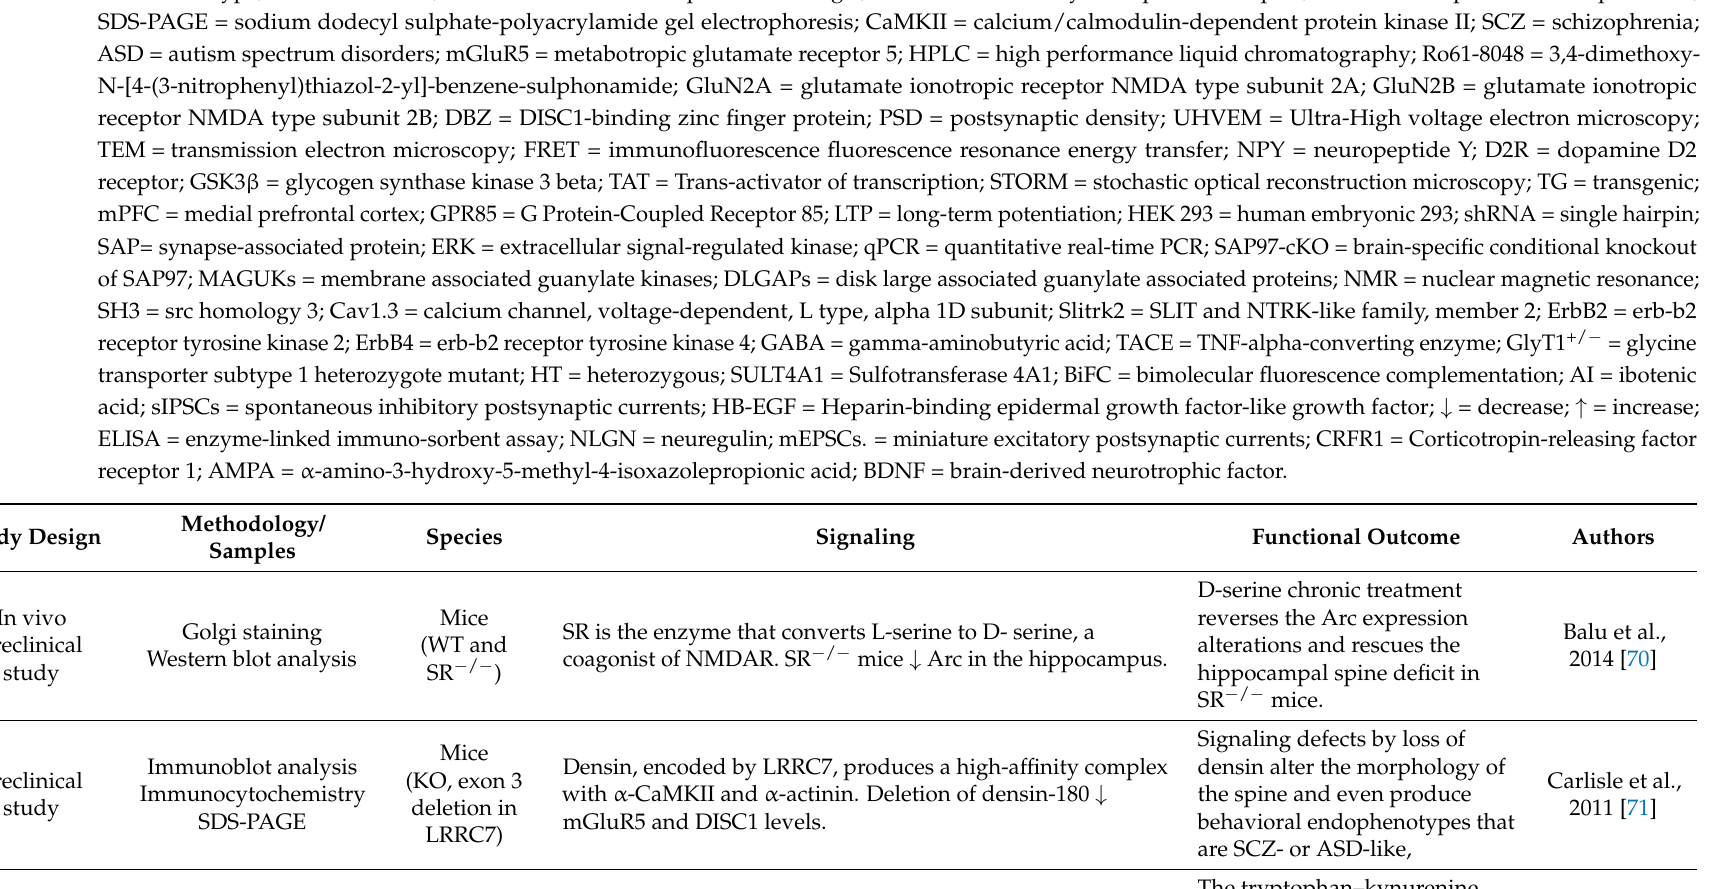
Table 1. PSD proteins expression and signaling. Arc = activity-regulated cytoskeleton-associated protein; SR = serine racemase; SR − / − = serine racemase knockout; WT = wild-type; KO = knock-out; LRRC7 = leucine rich repeat containing 7; NMDAR = N-methyl-D-aspartate receptor; DISC1= disrupted-in-schizophrenia 1; SDS-PAGE = sodium dodecyl sulphate-polyacrylamide gel electrophoresis; CaMKII = calcium/calmodulin-dependent protein kinase II; SCZ = schizophrenia; ASD = autism spectrum disorders; mGluR5 = metabotropic glutamate receptor 5; HPLC = high performance liquid chromatography; Ro61-8048 =